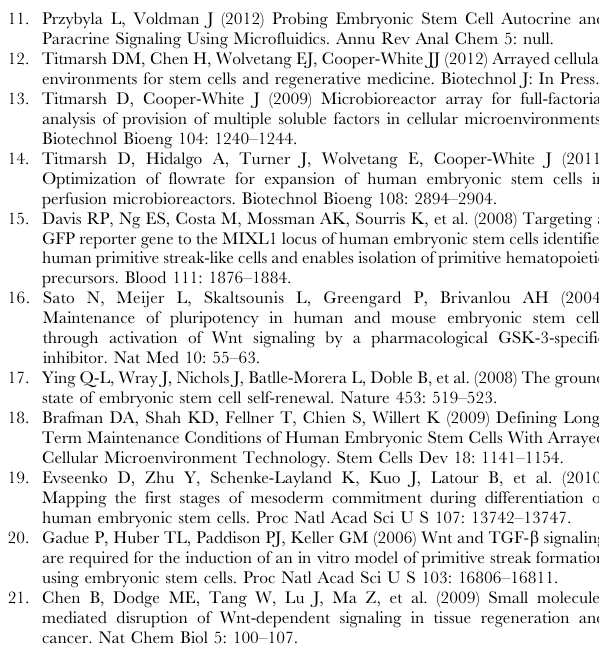
Figure S6 Factorial analysis of array data for HES3( MIXL1 GFP/ w ) hESCs – main effects. (a-c) Main effects plots mapping effect magnitudes of the individual factors Position, CM, IWP and CHIR on I DNA ( a ), I MIXL1-GFP ( b ), and I NCAM ( c ) expression indices. Units are 6 global standard deviations relative to global mean for each marker. Figure S7 Factorial analysis of array data for HES3( MIXL1 GFP/ w ) hESCs – interaction effects. (a-c) Interaction effects plots showing effect magnitudes for sets of two combined factors on expression index means for I DNA ( a ), I MIXL1-GFP ( b ), and I NCAM ( c ) expression indices. Units are 6 global standard deviations relative to global mean for each marker.